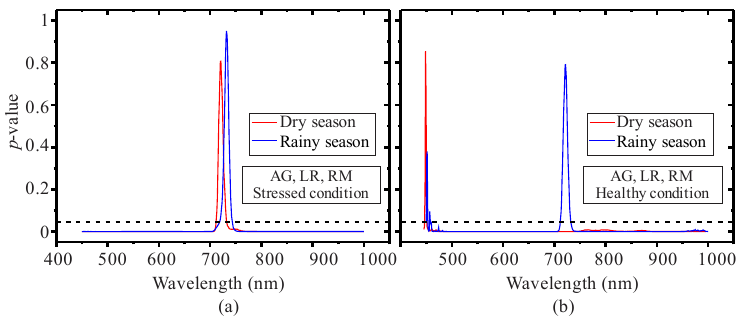
Figure 3. ANOVA p -plots among reflectance from the three mangrove species during the dry and rainy seasons for both stressed and healthy conditions: Avicennia germinans (AG), Laguncularia racemosa (LR), and Rhizophora mangle (RM). The flat black dashed line at the bottom of each graph represents p = 0.05. ( a ) AG, LR, and RM stressed condition; ( b ) AG, LR, and RM healthy condition Figure 4 shows pigment content variability for all six mangrove classes according to the seasons.